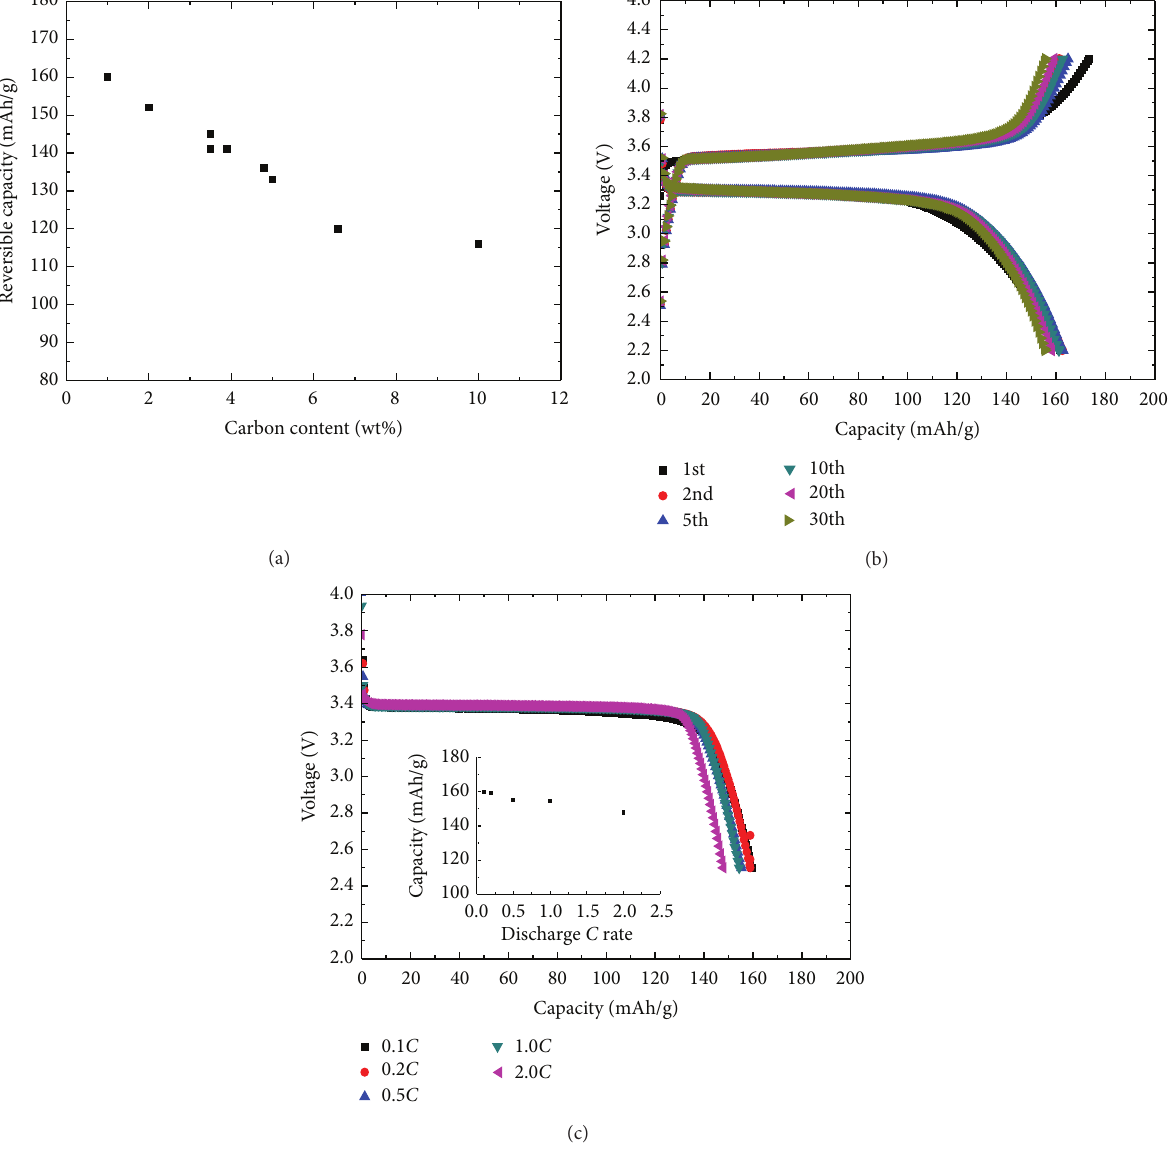
Figure 4: (a) The reversible capacity as a function of carbon content; (b) typical discharge/charge profiles of the LiFePO 4 /C with 1.0 wt% carbon obtained at 0.2 𝐶 rate; (c) discharge profiles of the LiFePO 4 /C with 1.0wt% carbon obtained at 0.2 𝐶 rate obtained at different 𝐶